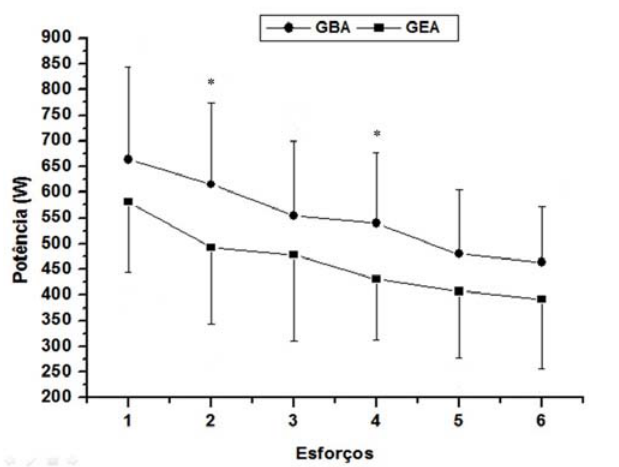
Figura 1. Diferenças entre os esforços do RAST para cada grupo. * Diferença significativa ( p